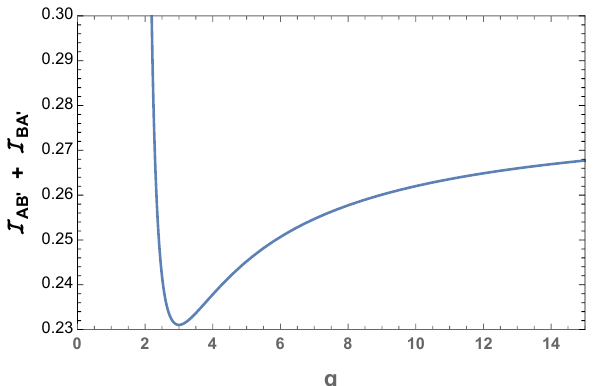
Figure 5: Here we set c = 1, a = 0, b = 2, and p = 3 / 2. The curve shows how the + I sum of the crossing PEEs I varies with respect to q . The sum reaches its AB (cid:48) BA (cid:48) minimal value of ( log2 ) / 3 = 0.231049 at q = 3, which is the balance point. < I then we enter the region close to B where I . Then it is natural to consider A ( d q ) B ( d q )